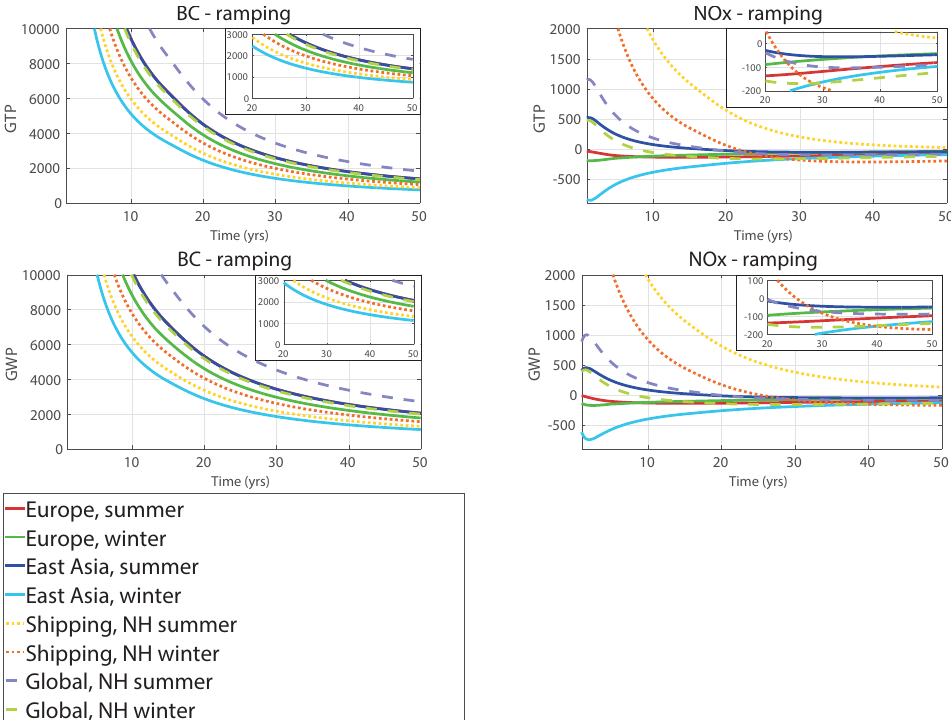
Figure 10. The emission metric values for ramping scenario emissions. GTP (top) and GWP (bottom) are given for BC (left) and NO x